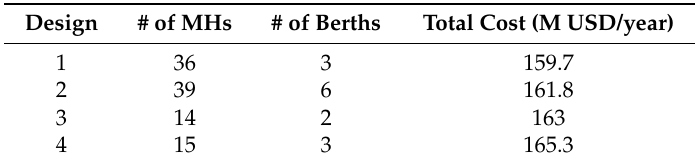
Table 4. Result of the simulation